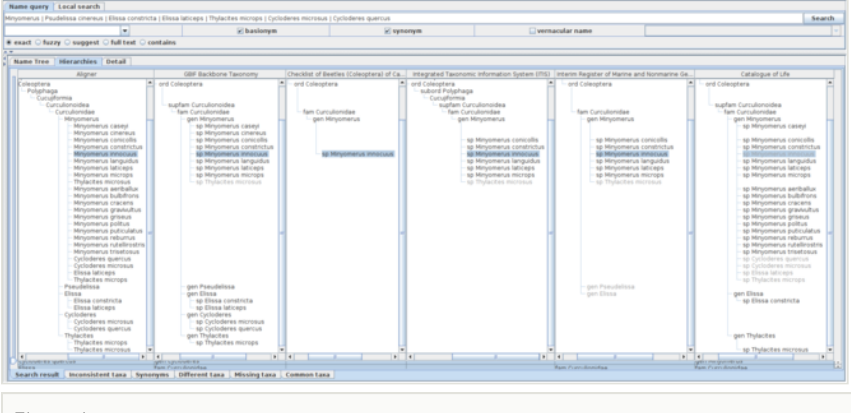
Figure 6. A screen shot showing hierarchical comparison of a union query of Minyomerus and relevant species names including their basionyms and synonyms. Name usages declared as synonyms in data sources are displayed in shaded characters. Union query of Minyomerus and relevant species names including their basionyms and synonyms returns extra records which are unavailable without these extensions. For example, Catalogue of Life returns Minyomerus innocuus which is not included in the child name usage set of Minyomerus although its higher name usage is speci fi ed as the Minyomerus usage. It is retained as a synonym of Minyomerus microps , which suggests that Minyomerus innocuus is not included in the child name usages because it is not an accepted name but the relationship to the higher name usage is recoverable via its accepted name, Minyomerus microps . The Minyomerus innocuus in Catalogue of Life was recovered by recursive query of synonyms through Minyomerus microps and Thylacites microps which is speci fi ed as a part of the union query. There are other synonyms of Minyomerus microps shown under the Minyomerus usage of Catalogue of